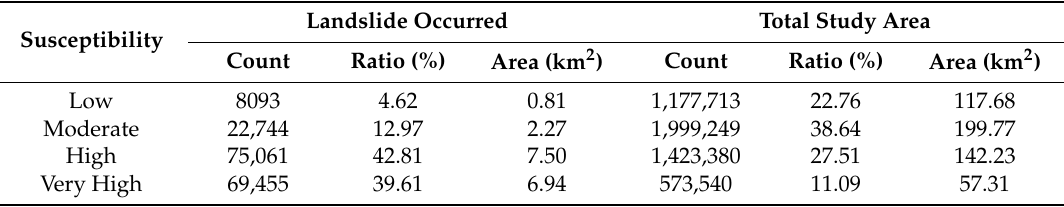
Table 5. Statistical results of landslide susceptibility mapping using slope units.